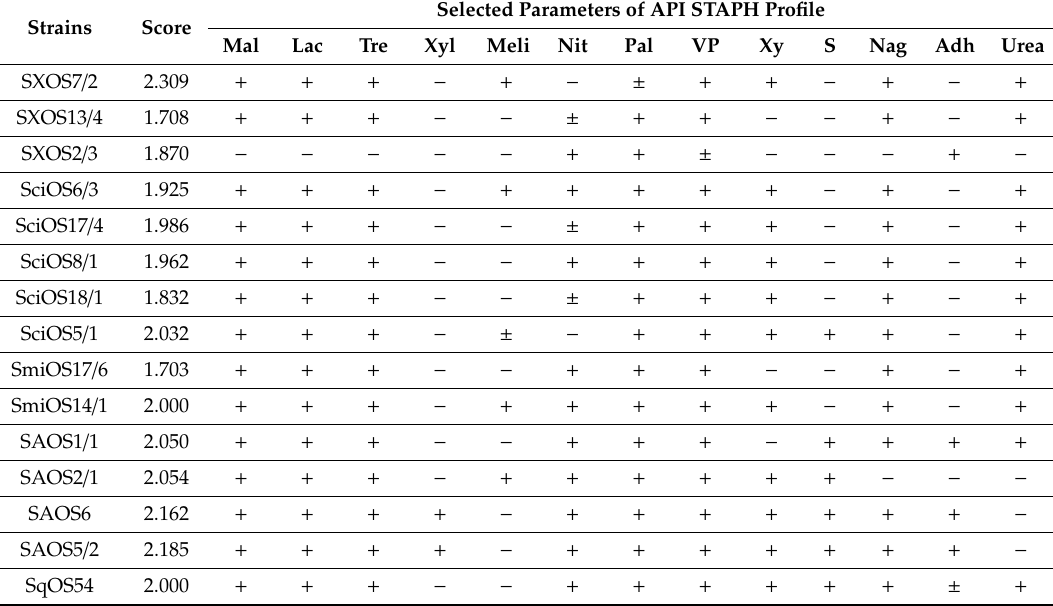
Table 1. Matrix–assisted laser desorption ionization time-of-flight (MALDI-TOF) spectrometry scores and phenotypization of staphylococci isolated from local Slovak ewes ‘milk lump cheeses. Strains Score